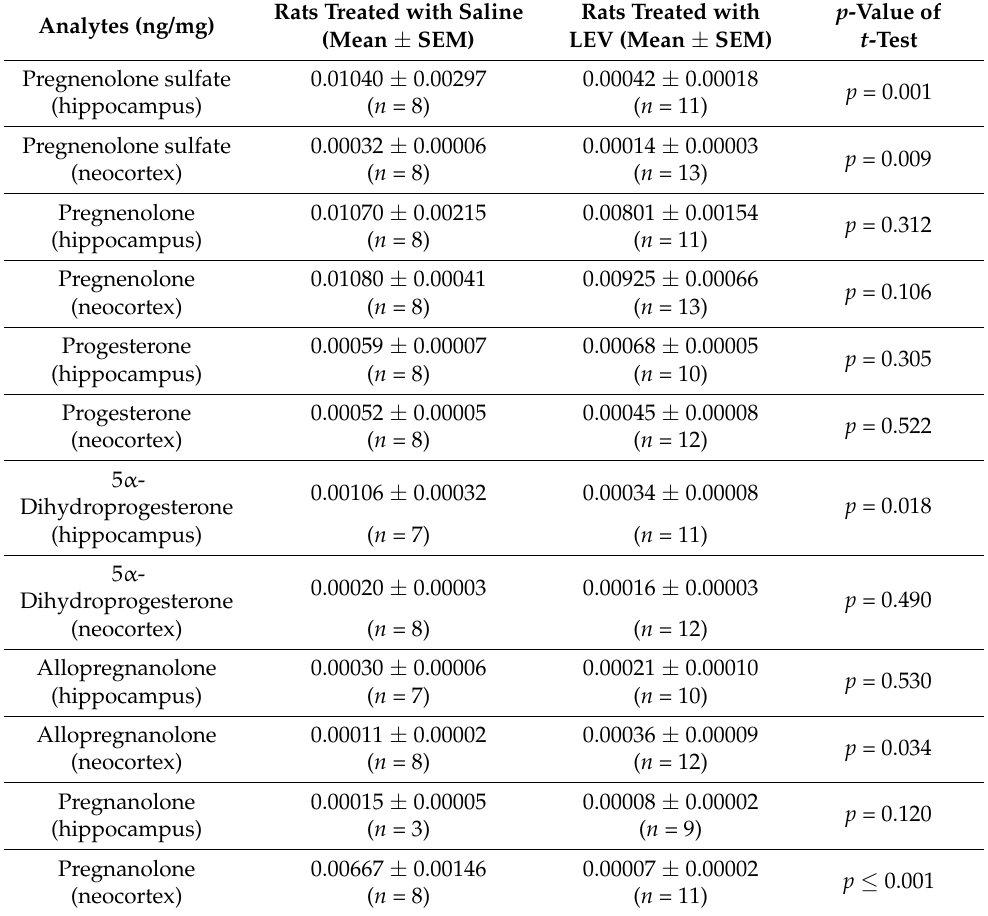
Table 1. Tissue levels of various neurosteroids in the hippocampus and neocortex of epileptic rats. Results are presented as mean ± standard error of the mean (SEM). Values under the limit of quantification (LOQ, Section 4.5) and outliers, identified by Grubbs’ test, were excluded. p -Value of Rats Treated with Saline Rats Treated with Analytes (ng/mg) t -Test (Mean ± SEM) LEV (Mean ± SEM) Pregnenolone